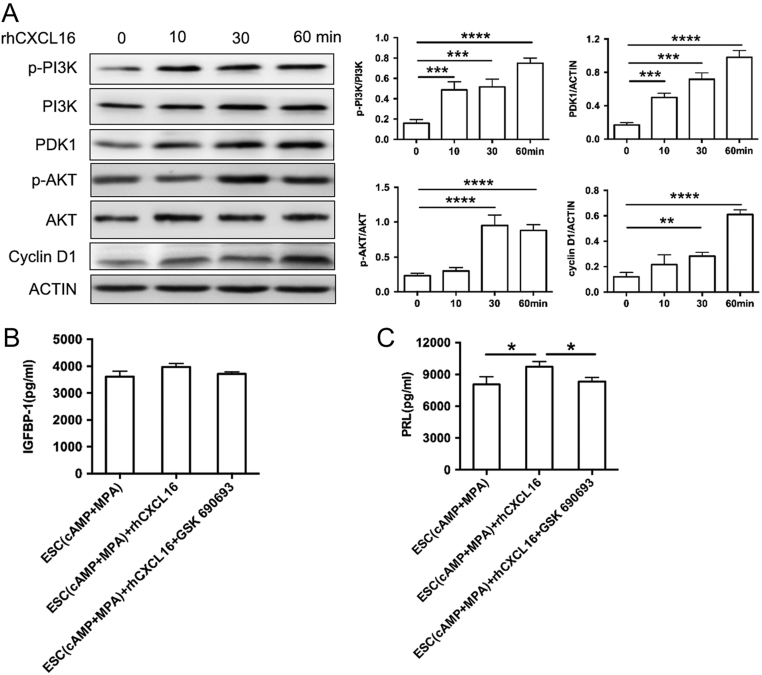
Signalling pathway activated by CXCL16 in ESCs decidualization. (A) In vitro-decidualised ESCs were incubated to 100 ng/mL rhCXCL16 and cell lysates were obtained at each of the indicated times up to 60 min (0, 10, 30, 60 min). Lysates were prepared for immunoblotting by using p-PI3K/PI3K, p-AKT/AKT and PDK1, Cyclin D1 antibodies (left panels), and the ratio of protein to actin (right panels) are shown. In vitro decidualised ESCs were treated with rhCXCL16, either in the presence or absence of the AKT signalling pathway inhibitor 10 µM GSK 690693 (10 µM, 24 h). The culture supernatants were collected for the detection of IGFBP-1 (B) and PRL (C) secretion. ESC (cAMP + MPA) + rhCXCL16 + GSK 690693, in vitro decidualised ESCs treated with rhCXCL16 and GSK 690693; ESC (cAMP + MPA) +rhCXCL16, in vitro-decidualised ESCs treated with rhCXCL16; ESC (cAMP + MPA), in vitro-decidualised ESCs, ESCs incubated with MPA plus cAMP. Data are expressed as the mean ± s.d. (n = 6). *P < 0.05.